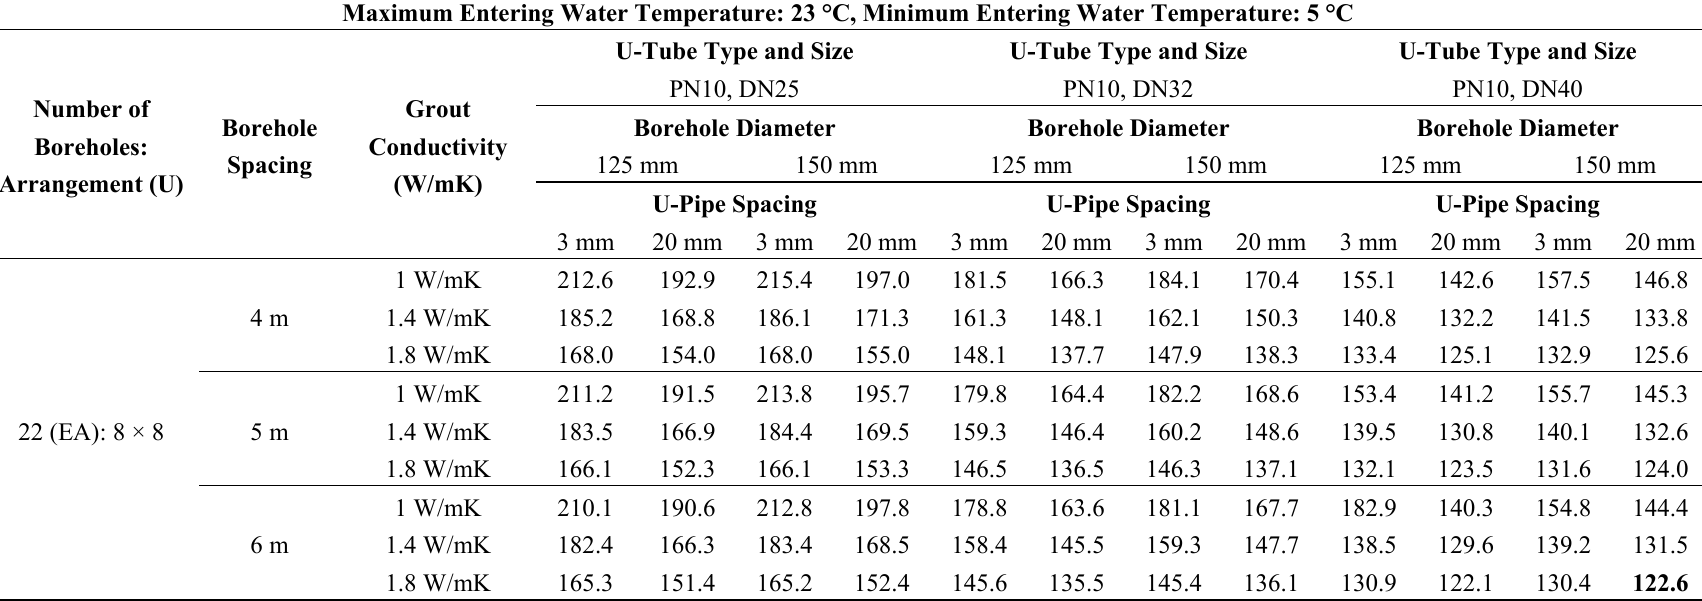
Table A3. Scenarios (length of borehole) of GHE considering EWT (25 °C) and characteristics of